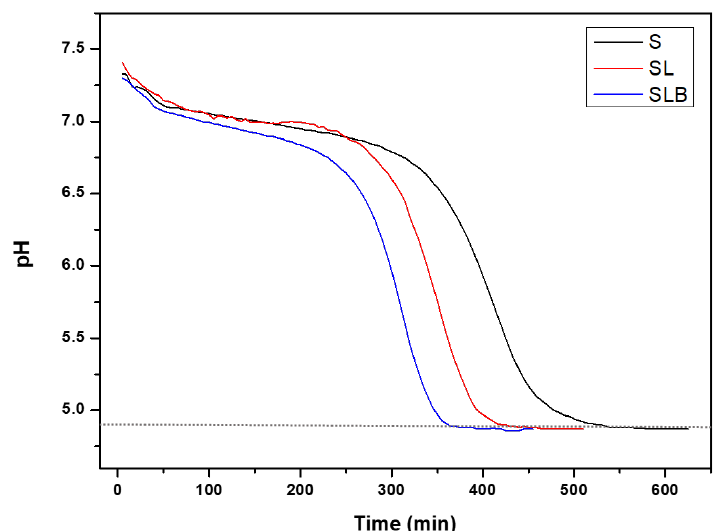
Figure 2. Acidification kinetics of bacteria (Streptococcus thermophilus (S), Streptococcus ther- mophilus + Lactobacillus acidophilus (SL), Streptococcus thermophilus + Lactobacillus acidophilus + Bifidobacterium lactis (SLB)) during the acid precipitation step of pea protein extraction .